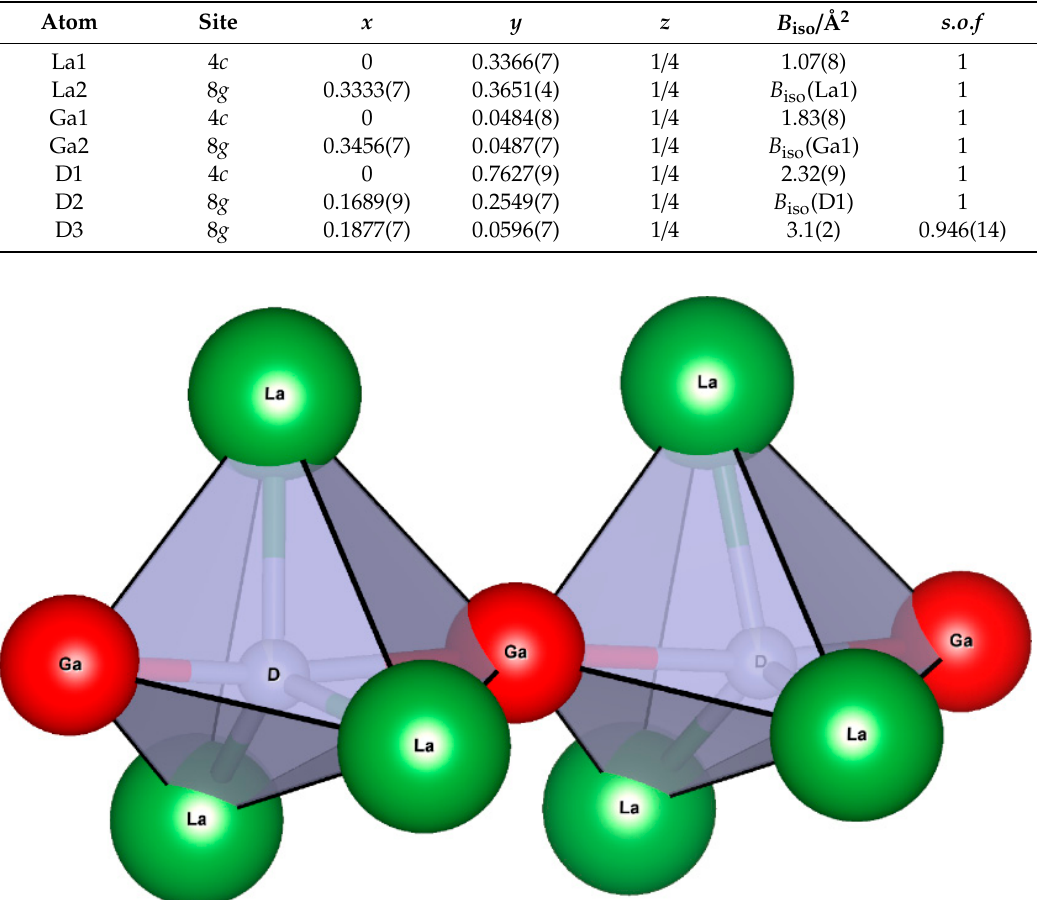
Table 1. Crystal structure of LaGaD 1.63(1) derived from neutron di ff raction data, Cmcm , a = 12.7414(6) Å, b = 12.6178(6) Å, c = 4.2589(2) Å.